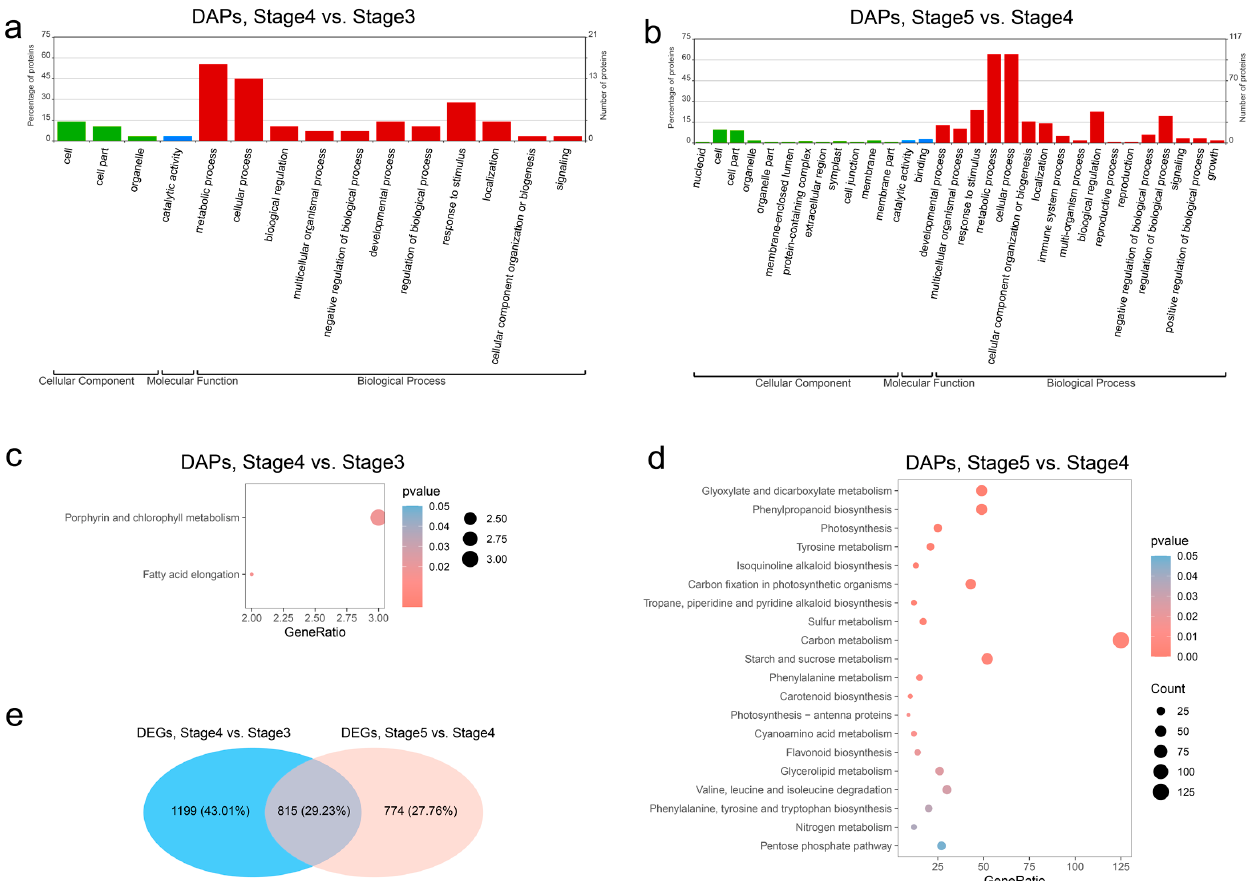
Figure 3. Functional analysis of differentially abundant proteins (DAP). ( a ) GO classifications of DAPs between stage 4 and stage 3. ( b ) GO classifications of DAPs between stage 5 and stage 4. ( c ) KEGG pathways enrichment of DAPs between stage 4 and stage 3. ( d ) KEGG pathways enrichment of DAPs between stage 5 and stage 4. ( e ) Venn plot between DEGs of stage 4 vs. stage 3 and DEGs of stage 5 vs. stage 4.